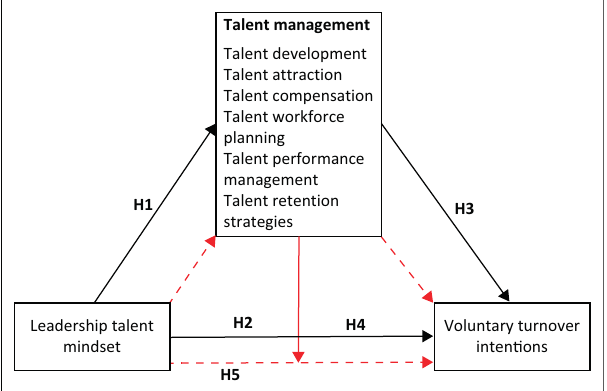
FIGURE 1: Hypothesised model for the